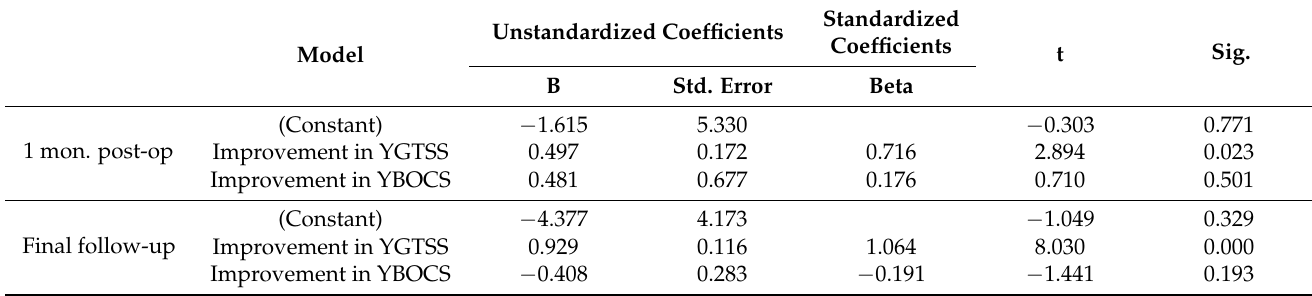
Table 6. Coefficients of the multiple linear regressions for the improved score of GTS-QOL.